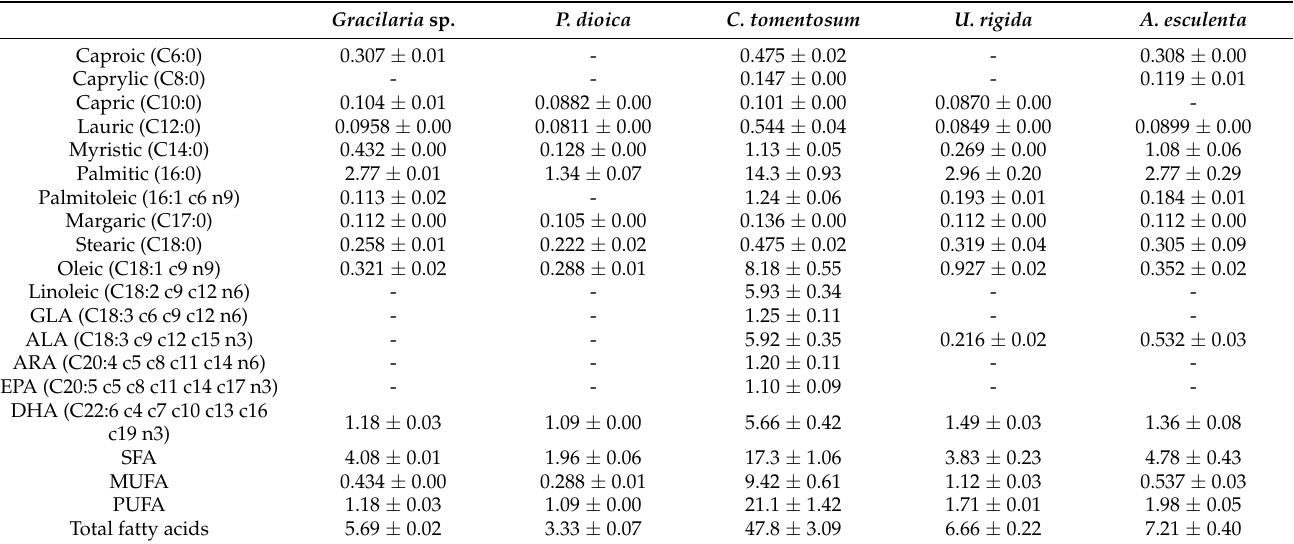
Table 3. Fatty acid profile of seaweeds (mg g − 1 dry